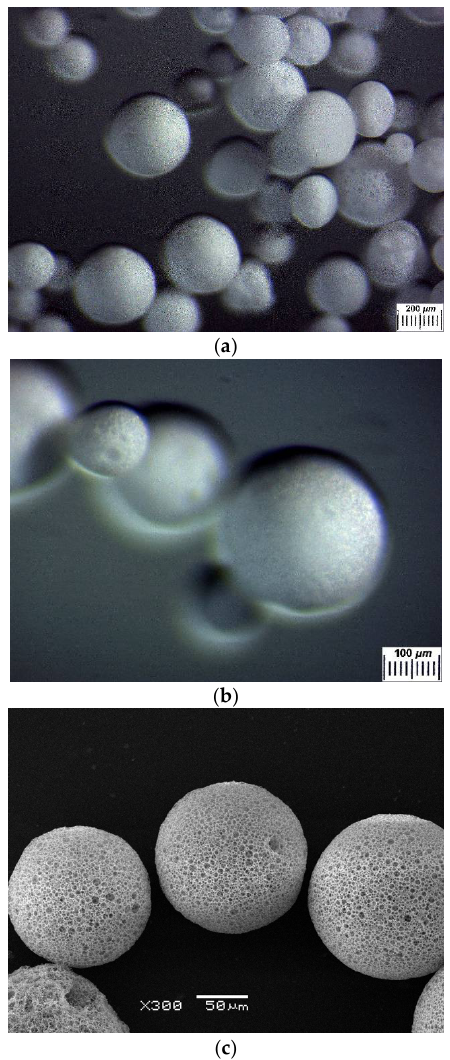
Figure 1. Optical stereomicroscopy microphotographs ( a , b ), as well as SEM microphotograph ( c ) of the dry PHB-based spherical particles prepared as described in Section 3.2.1.